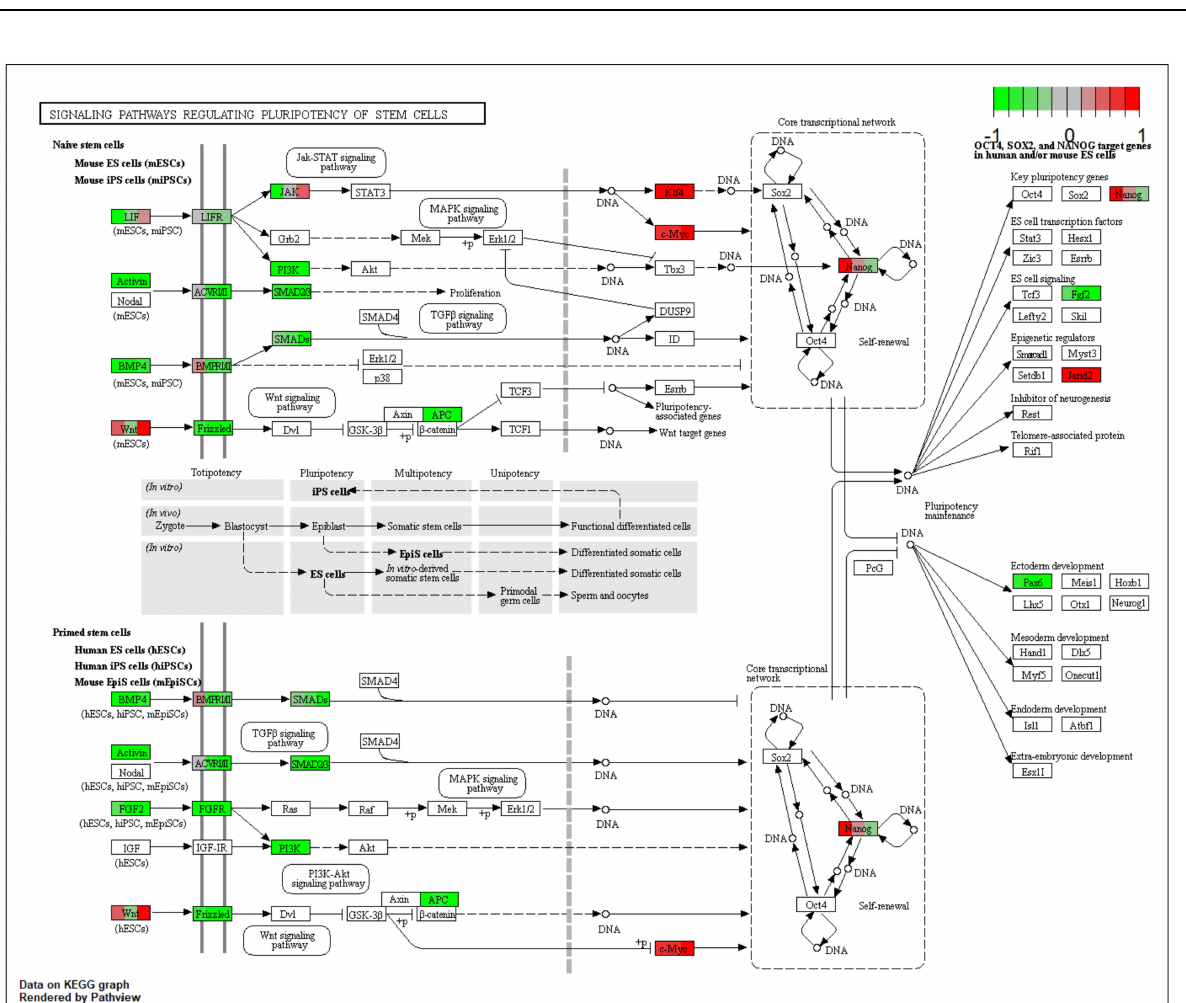
Figure 2. ‘Signaling pathways regulating pluripotency of stem cells’ KEGG pathway. Arbitrary signal intensity acquired from microarray analysis is represented by colors (green, higher; red, lower expression). Each gene of interest is assigned three colors, each representing change in expression levels between D7/D1, D15/D1 and D30/D1, respectively. KEGG, Kyoto Encyclopedia of Genes and Genomes; D, day of culture. Copyright permission